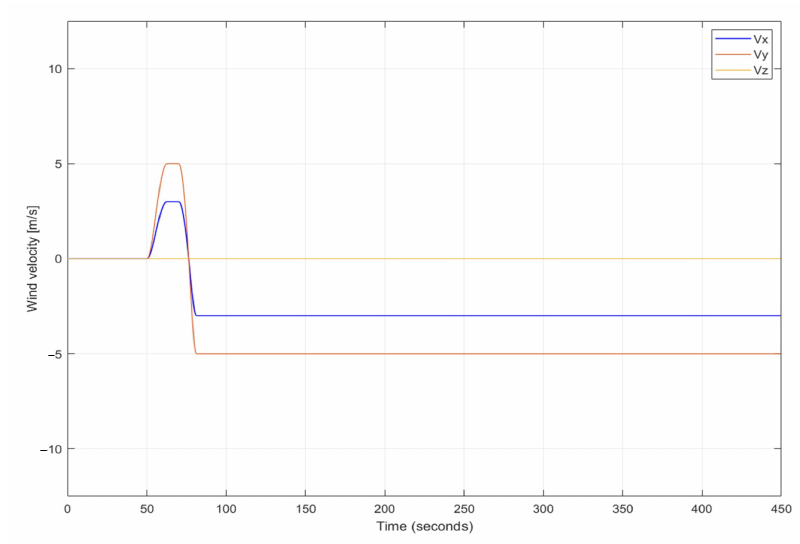
Figure 8. Simultaneous discrete wind gusts along x and y axes at 50th second and changing its directions to opposite at 75th